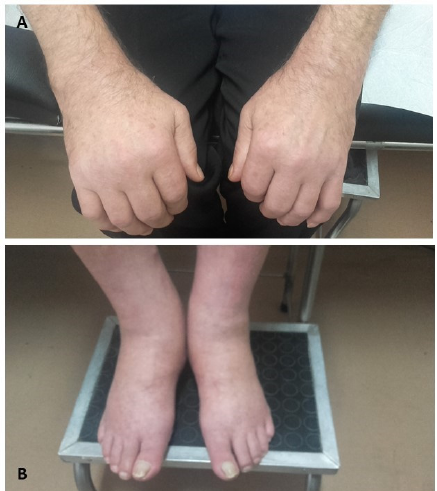
Figure 2. A 65-year-old male with renal cell carcinoma developed di ff use, painful swelling of hands ( A ) and feet ( B ), 3 months following nivolumab treatment (Rheumatology Department of Patras University Hospital photo